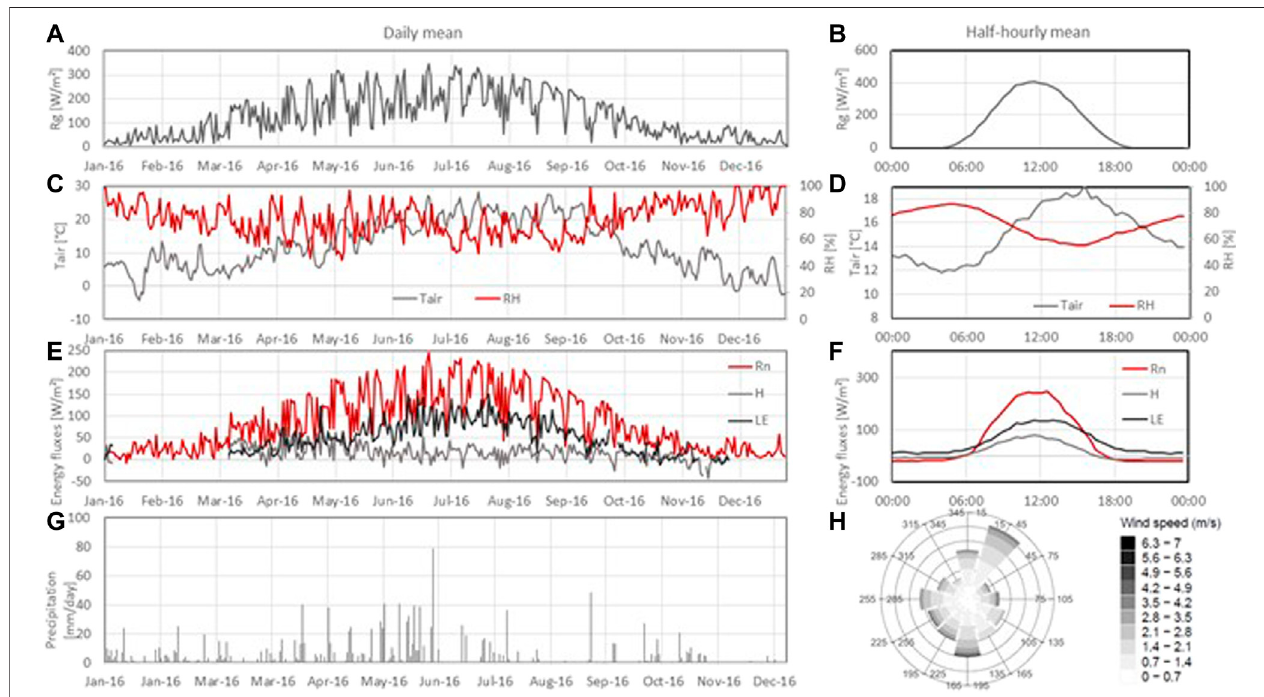
FIGURE4| Daily(left)andhalf-hourly(right)meansof (A,B) globalradiation(Rg), (C,D) relativehumidity(RH)(redline)andairtemperature(Tair)(greyline),and (E,F) net radiation (Rn) (red line), sensible heat fl ux (H) (grey line) and latent heat fl ux (LE) (black line). (G) Daily cumulated precipitation and (H) wind rose of half-hourly mean wind